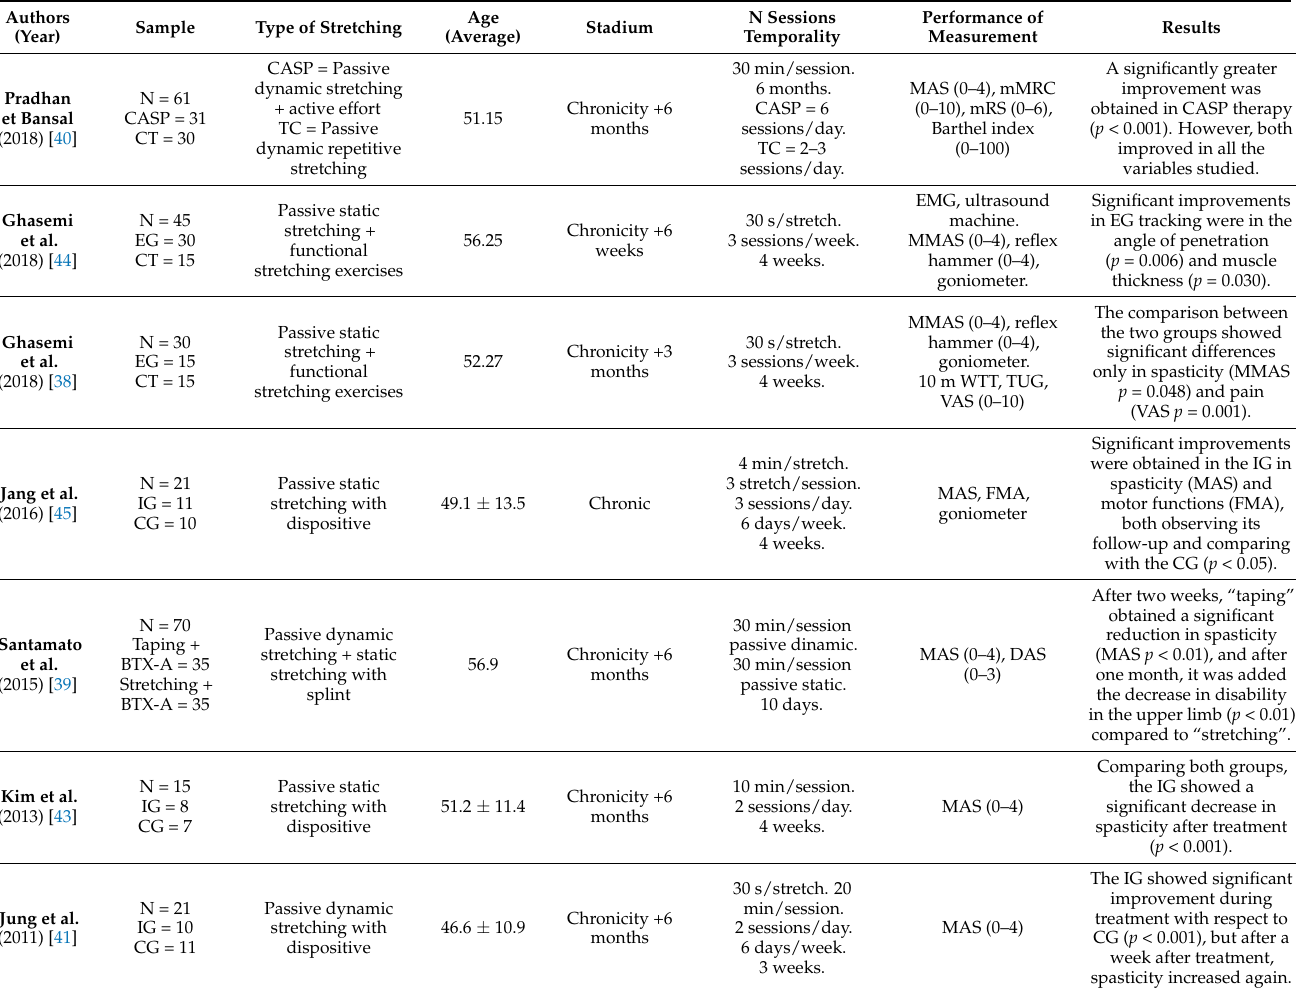
Table 3. Synthesis of